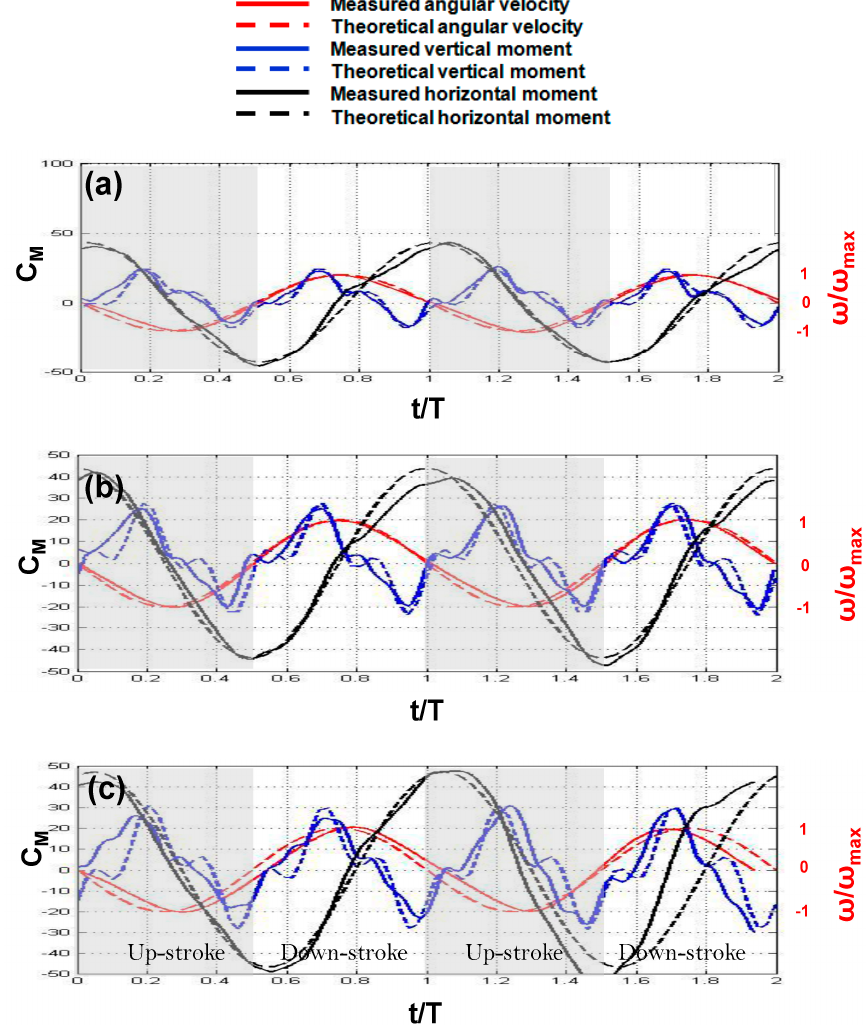
Figure 18. Non-dimensional in-plane and out-of-plane bending moments at the wing’s root vs. non-dimensional time (T is the period of flapping), at Re = 14,000 and ( a ) AOA = 5°; ( b ) AOA = 12°; ( c ) AOA = 15°.